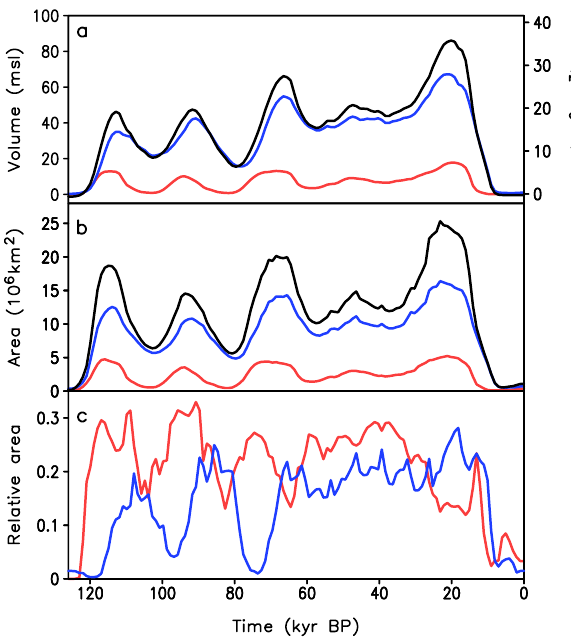
Fig. 7. Simulated components of the mass balance of the NH ice sheets. (a) Total accumulation (solid blue) and ice-sheet area (dashed black). (b) Total surface melting (blue) and maximum sum- mer insolation at 65 ◦ N (red dashed line). (c) Total ice calving. Units are Sverdrups of water (1Sv=10 6 m 3